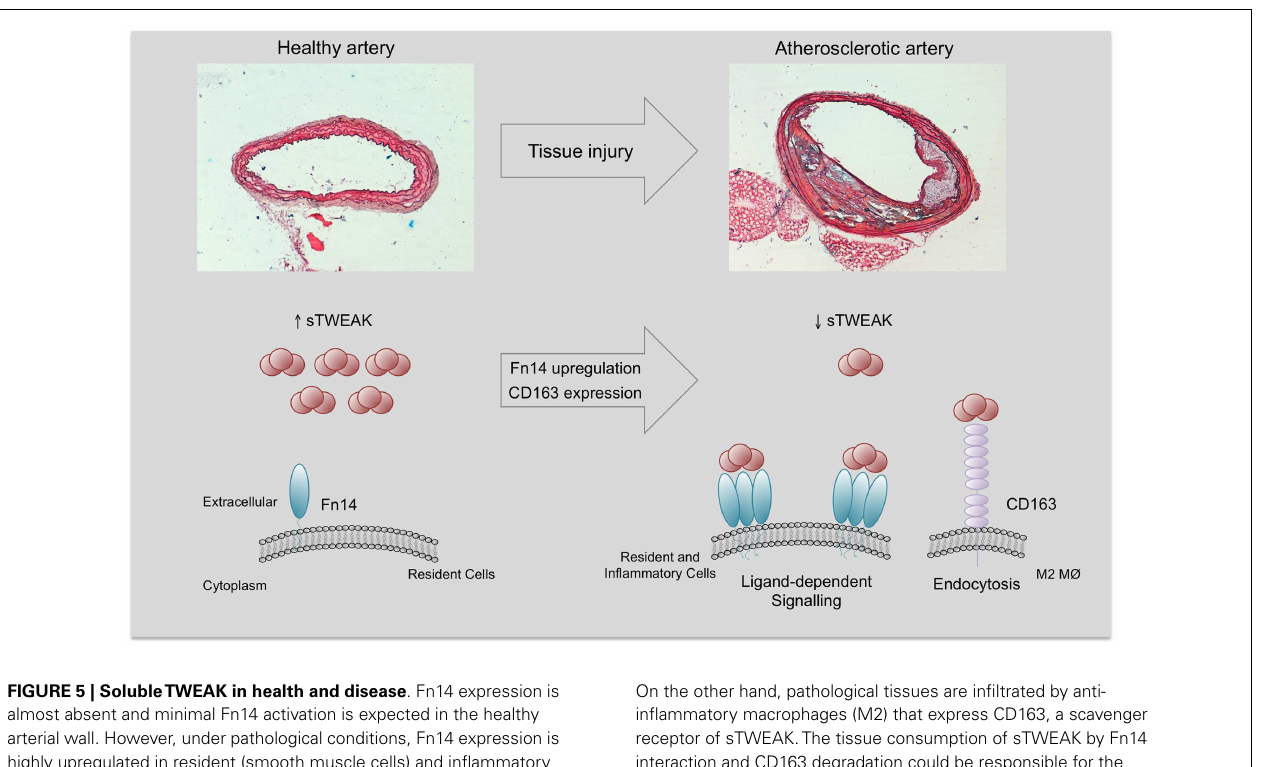
On the other hand, pathological tissues are infiltrated by anti- inflammatory macrophages (M2) that express CD163, a scavenger receptor of sTWEAK.The tissue consumption of sTWEAK by Fn14 interaction and CD163 degradation could be responsible for the decrease in circulating sTWEAK levels observed in subjects with atherosclerostic complications.